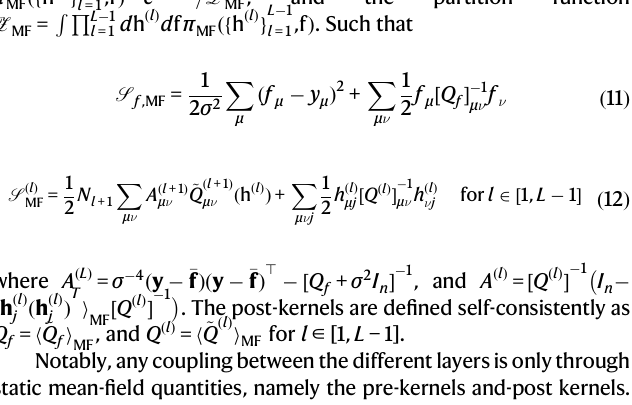
Fig. 6 | Pre-activation statistics for the myrtle-5 CNN with ReLU activation and C =256, trainedon n =2048CIFAR-10 images. a , b Statisticsofpre-activations of untrained (gray) and trained (blue) Myrtle-5 nets, in the 2nd layer. The histograms are aggregations over channels and initialization seeds of the pre-activations, projected on various eigenvectors of the corresponding kernel matrix. a A pro- jection on the 1st (leading) eigenvector, while b is the same for the 10th eigen- vector. c , d Arethesameas a , b ,butforthe4thlayer.The fi tstoaGaussian(dashed lines) provide an accuracy measure for our variational Gaussian approximation. Notice that the equilibrium distribution, even when it is near Gaussian, can differ